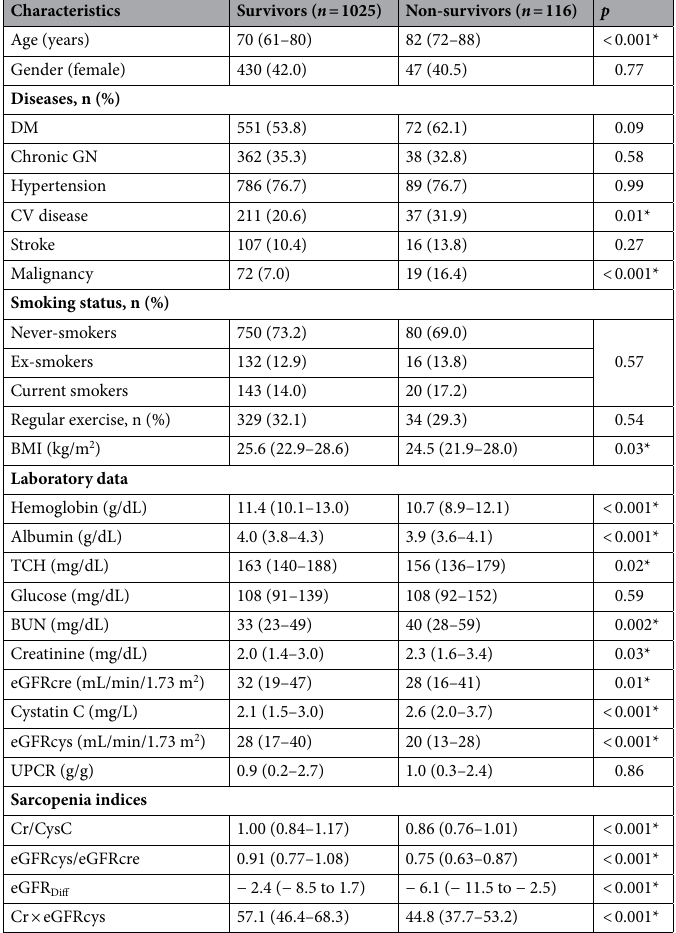
Table 2. Comparisons of clinical characteristics between the survivors and non-survivors. Values for continuous variables are given as means ± standard deviations or medians and interquartile ranges. Categorical variables are expressed as numbers (%). DM diabetes mellitus, GN glomerulonephritis, CV cardiovascular, BMI body mass index, TCH total cholesterol, BUN blood urea nitrogen, eGFRcre estimated glomerular filtration rate from serum creatinine, eGFRcys estimated glomerular filtration rate from serum cystatin C, UPCR urine protein/creatinine ratio,